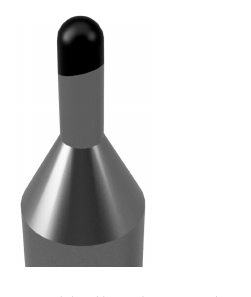
Figure 4. Appearance of the used ball radius tooling. The tip is coated.